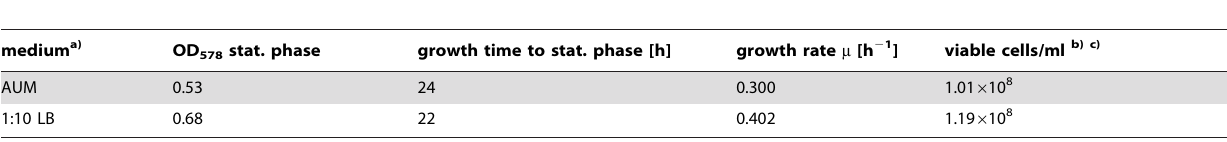
Table 1. Growth of P. aeruginosa PAO1 at 37 u C as biofilms on membrane filters placed on the surface of agar media containing AUM or 10-fold diluted LB, respectively.